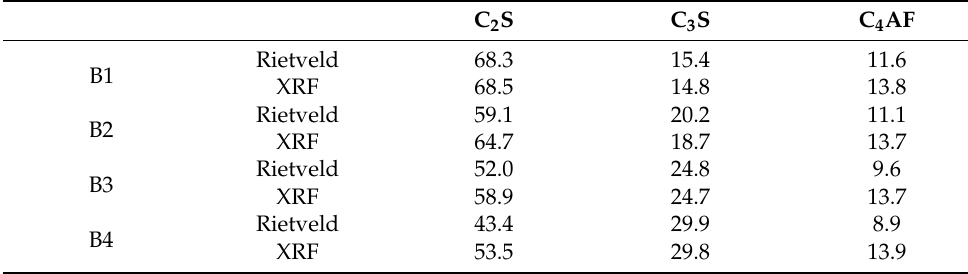
Table 7. Phase composition (wt.%) of B1–B4 sintered at 1350 ◦ C, for 30